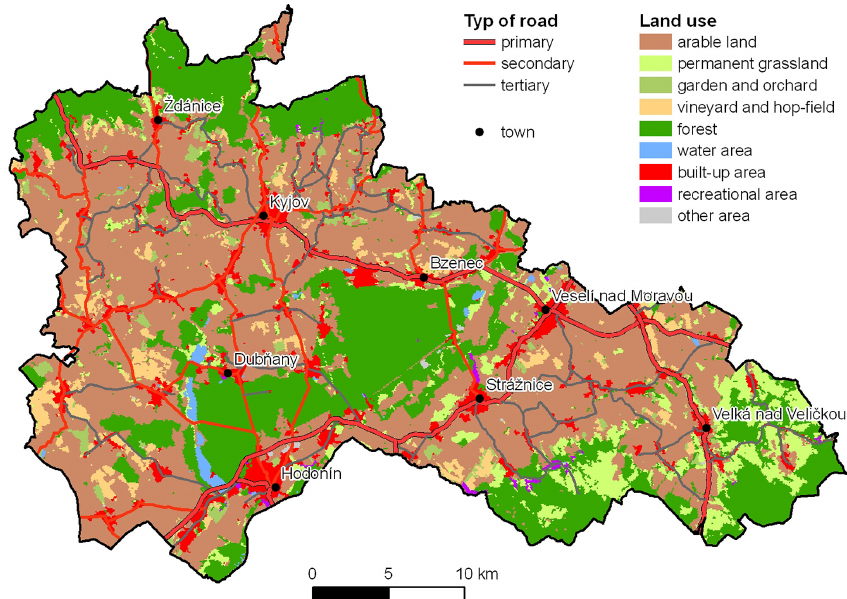
Fig. 6. The road network and land use in the Hodonín region in the 2010s.